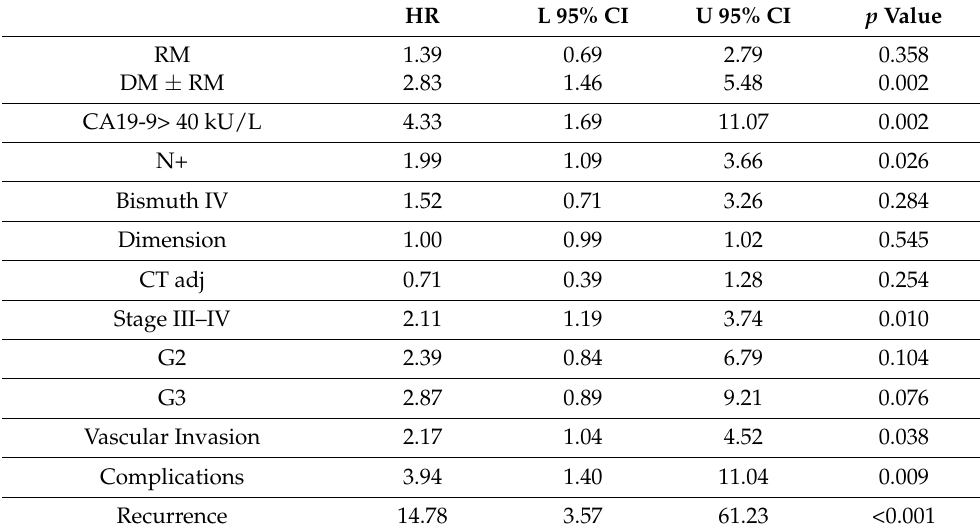
fied as independent prognostic factors for survival (Table 5).